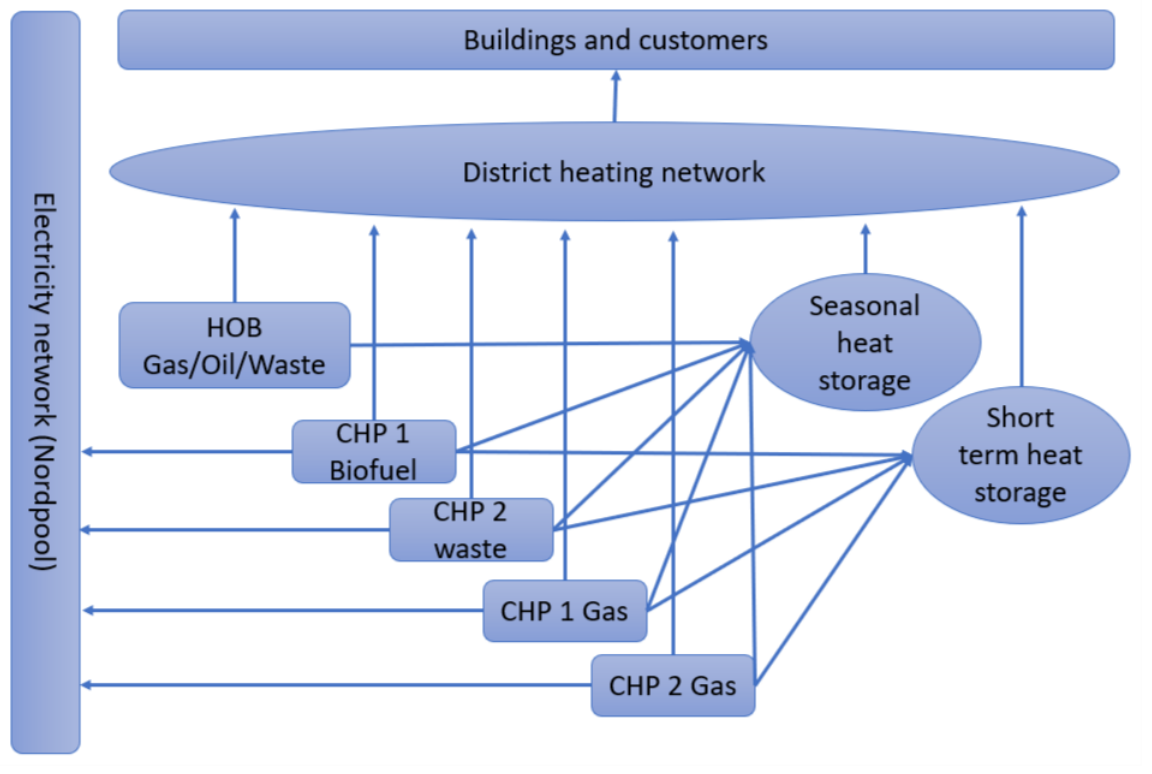
Figure 1. Model of the optimised energy system.